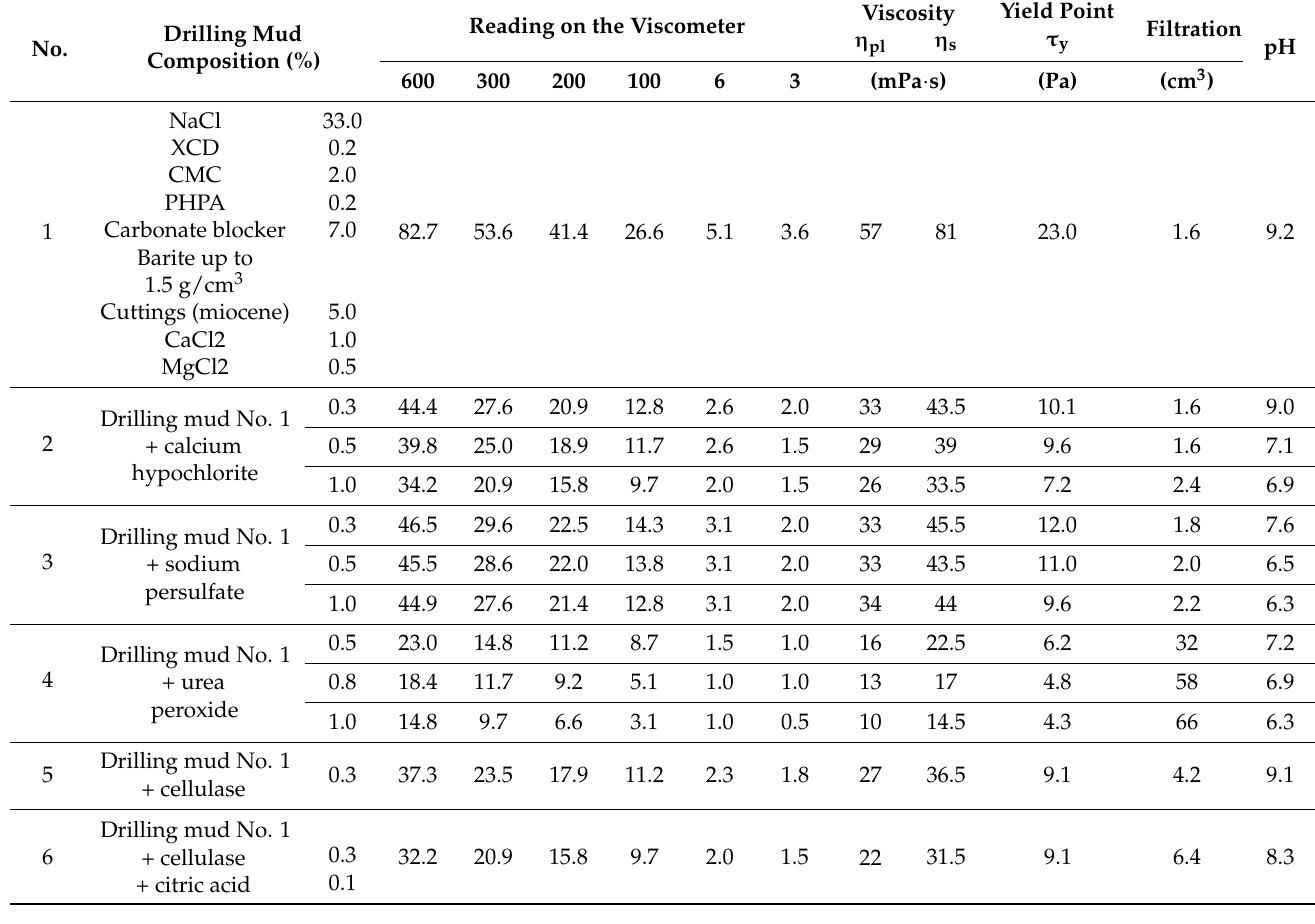
Table 5. The properties of salt-barite drilling mud C, density 1530 kg/m 3 , with the addition of oxidizing agents and cellulase enzyme.